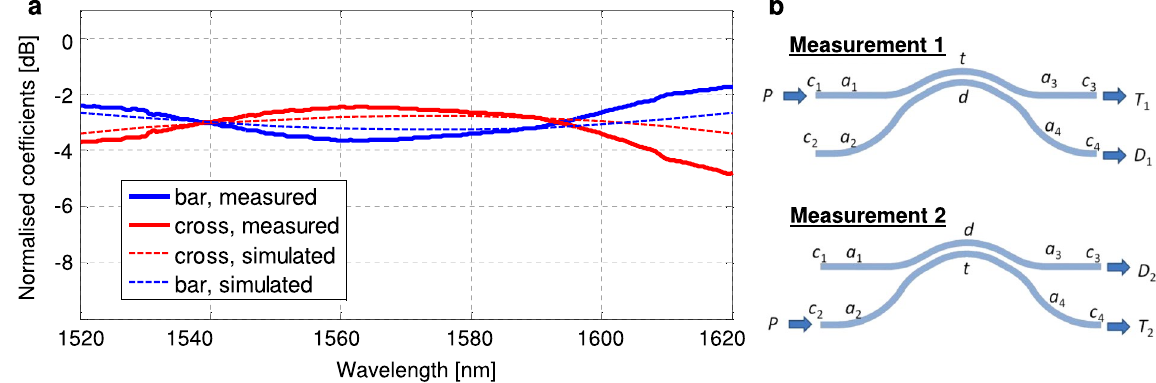
Figure 4. Measured normalised bar and cross coefficients of the fabricated curved directional coupler. The dotted line indicates simulated results as a comparison. (inset) Layout diagram of measurement 1 and measurement 2, indicating different inputs, outputs and sources of